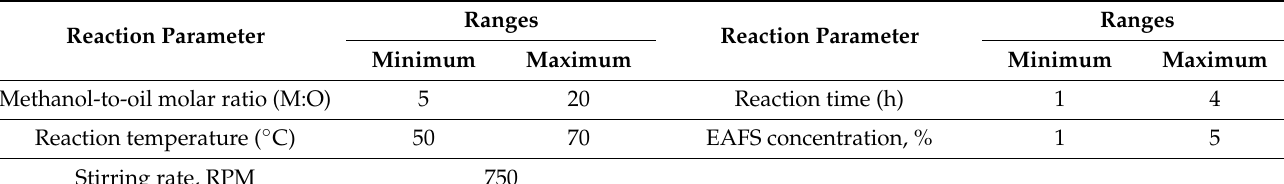
Table 3. Transesterification reaction parameters .